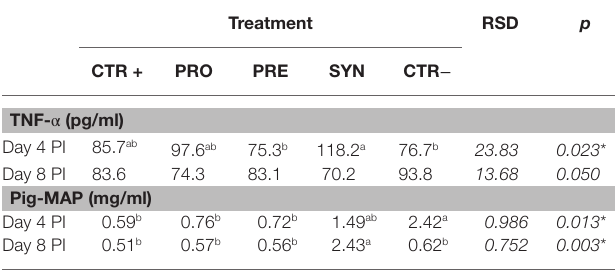
TABLE 6 | Effect of experimental treatments in serum levels of acute-phase protein Pig-MAP and TNF- α .